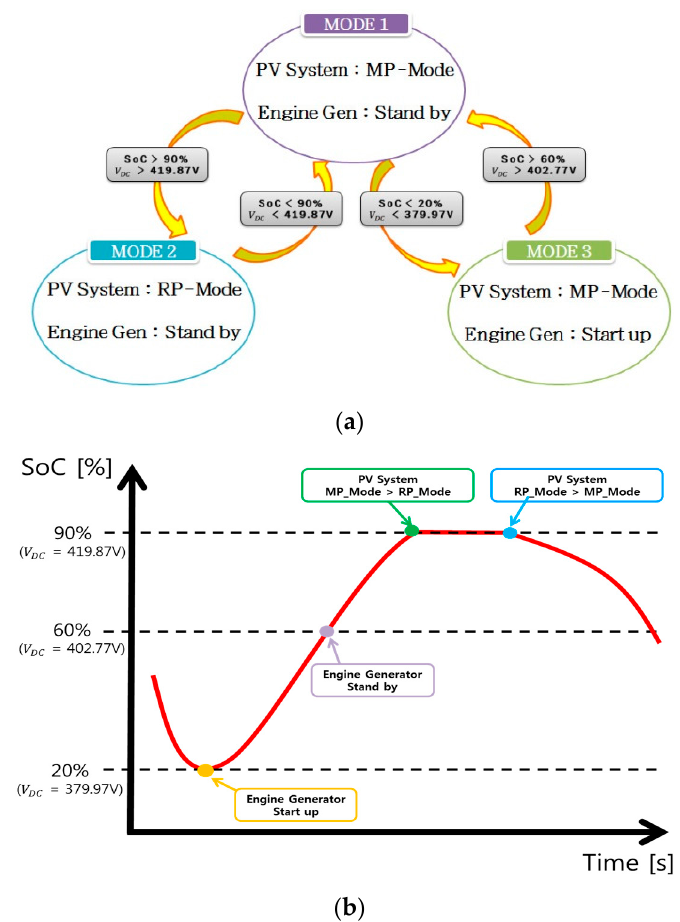
Figure 9. System operation mode with respect to SoC variation: ( a ) state transition; and ( b ) SoC operation range.